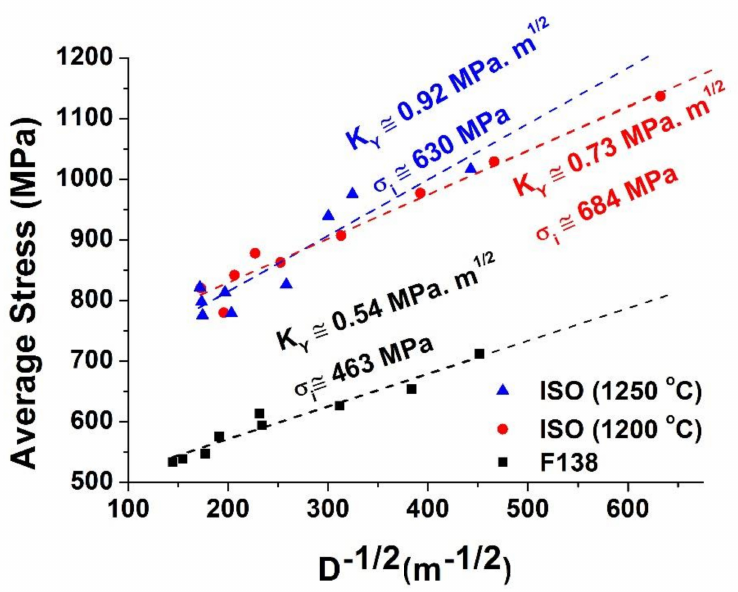
Figure 14. Hall–Petch plot corresponding to the present experimental results for the F138 and ISO